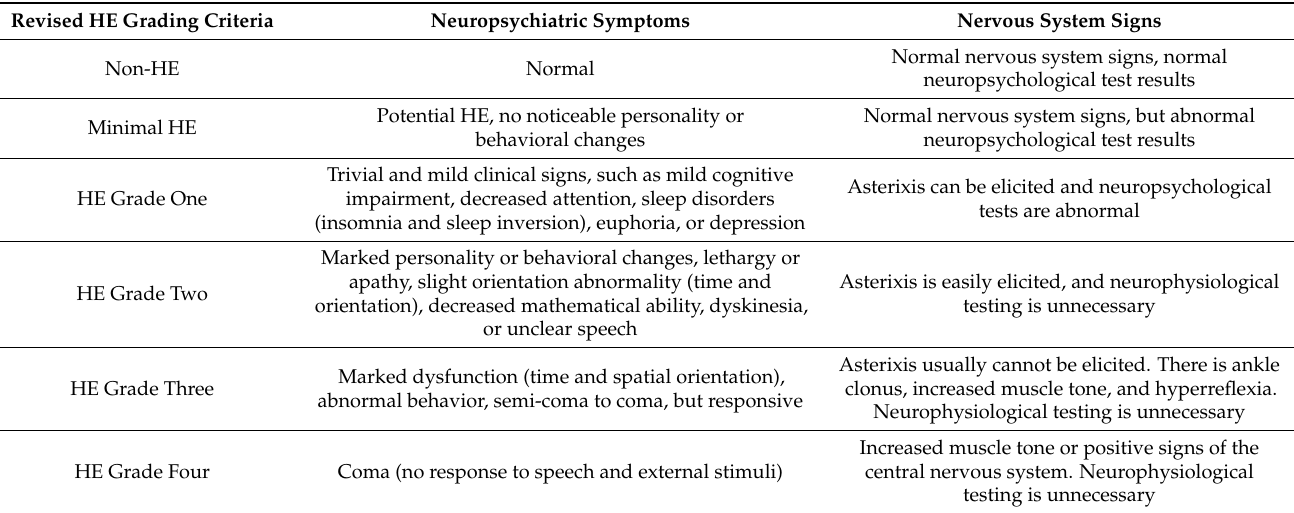
Table 1. Classification of hepatic encephalopathy (HE) in patient with